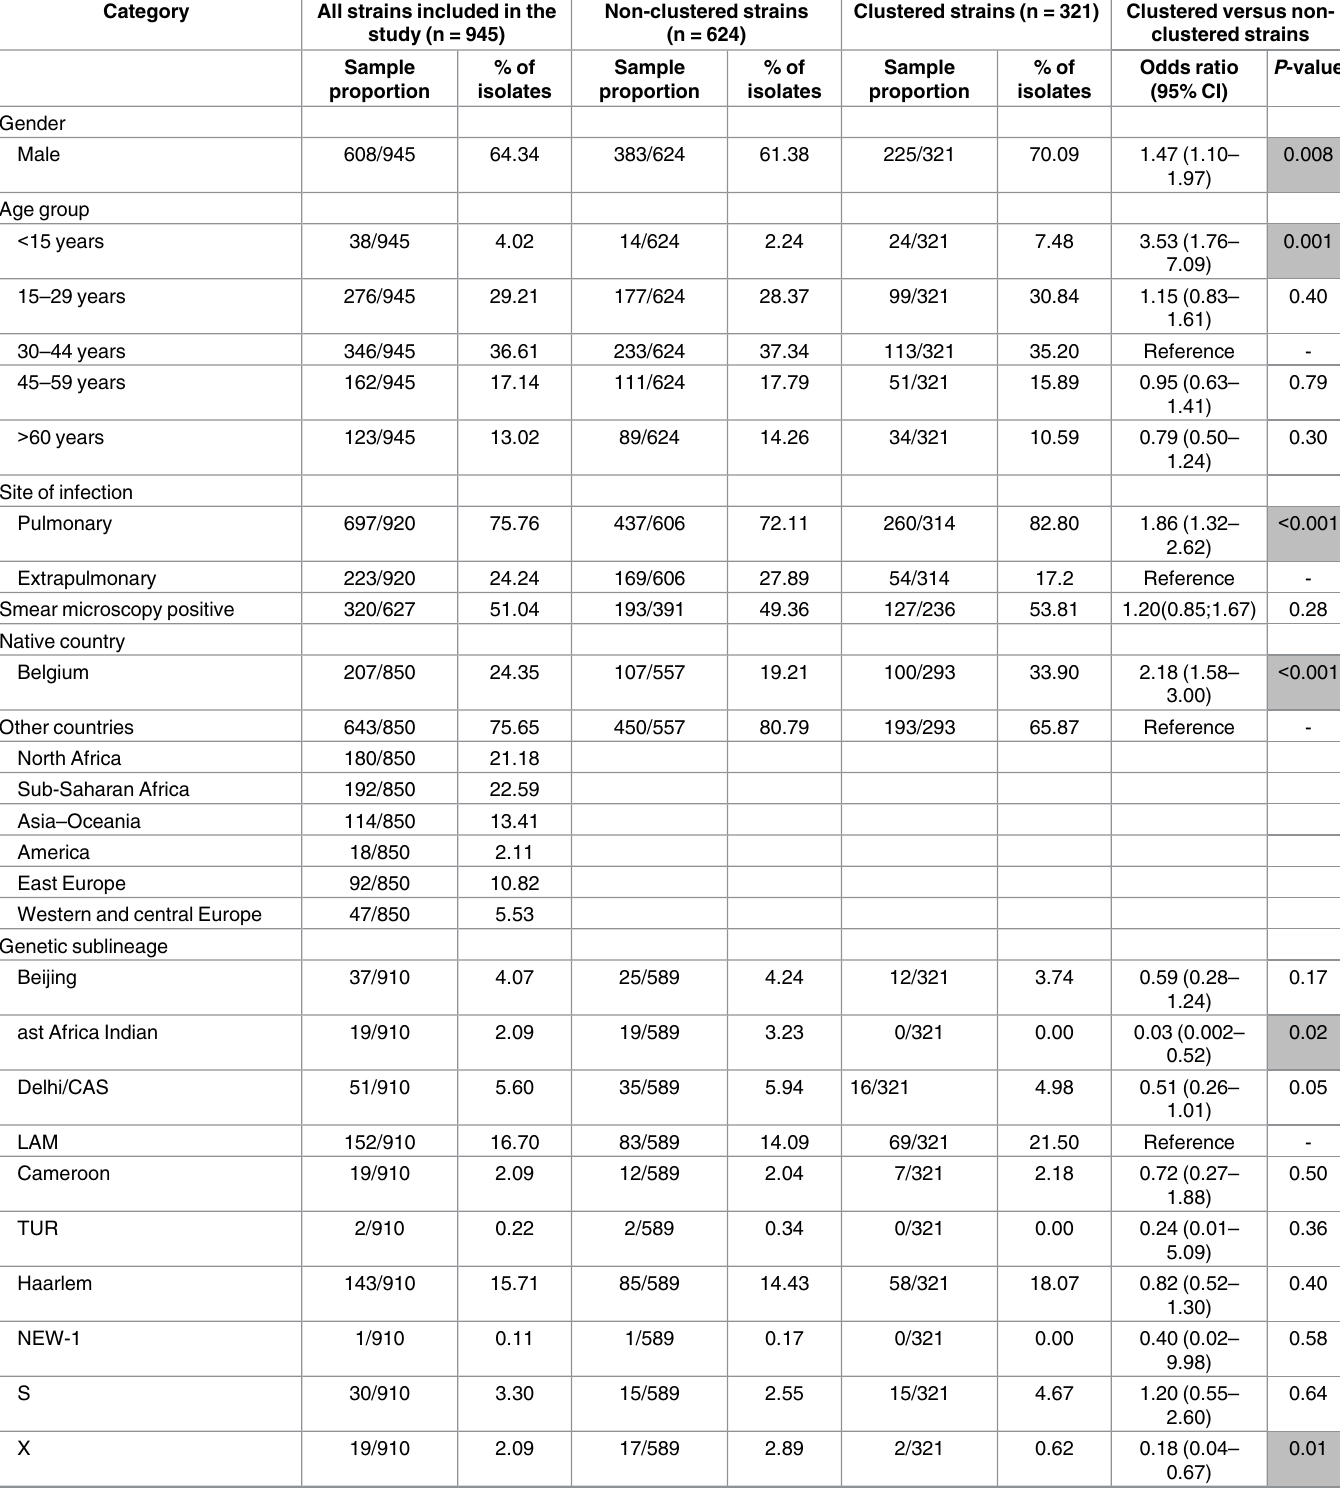
Table 1. Characteristics of Mycobacterium tuberculosis complex strains isolated from tuberculosis patients living in Brussels and two sub- groups; no-clustered and clustered strains,